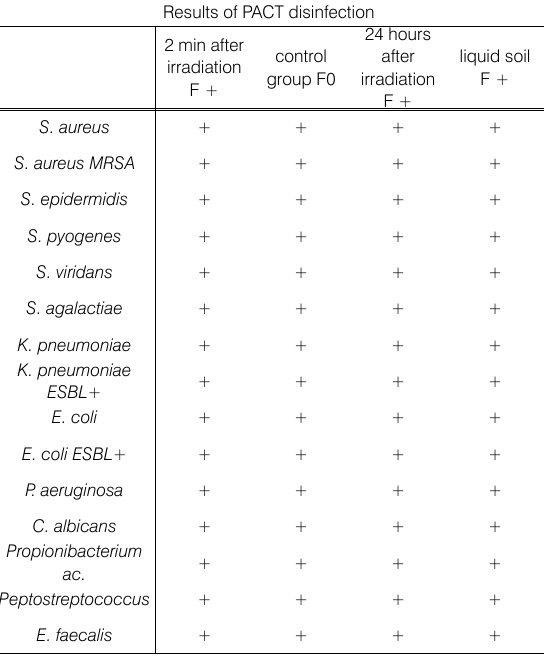
Table 1. Results of PACT